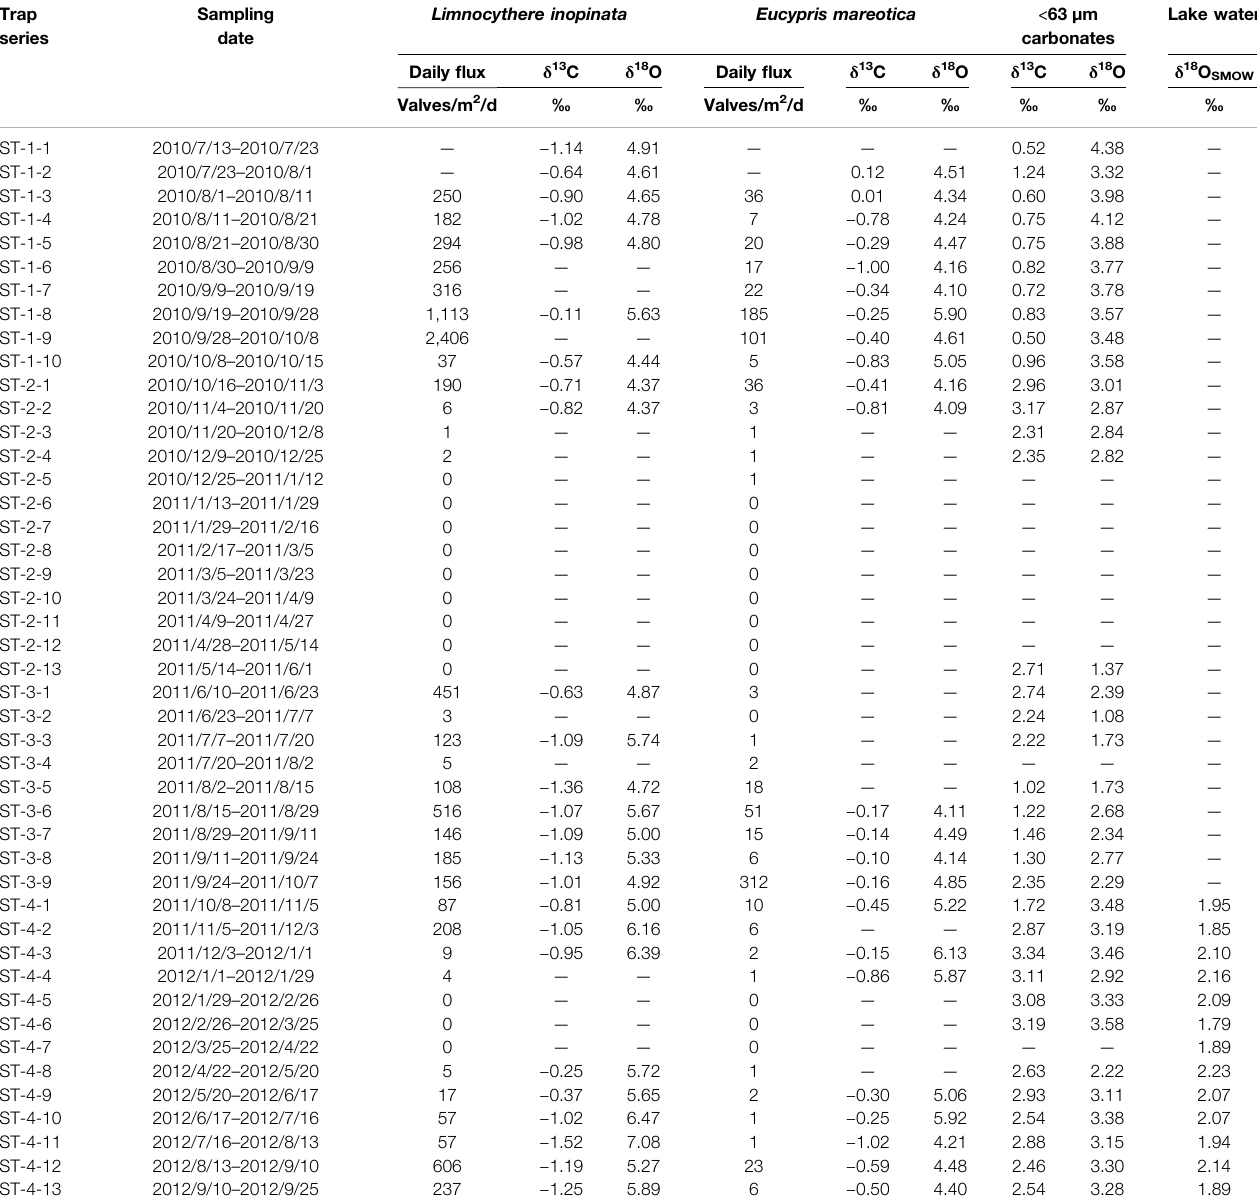
TABLE 1 | Oxygen and carbon isotopic compositions for two species of adult ostracod shells ( L. inopinata and E. mareotica ) and carbonates of the < 63 μ m sediment fraction, and δ 18 O of lake water collected by a time-series sediment trap during July 2010 through September 2012 in Lake